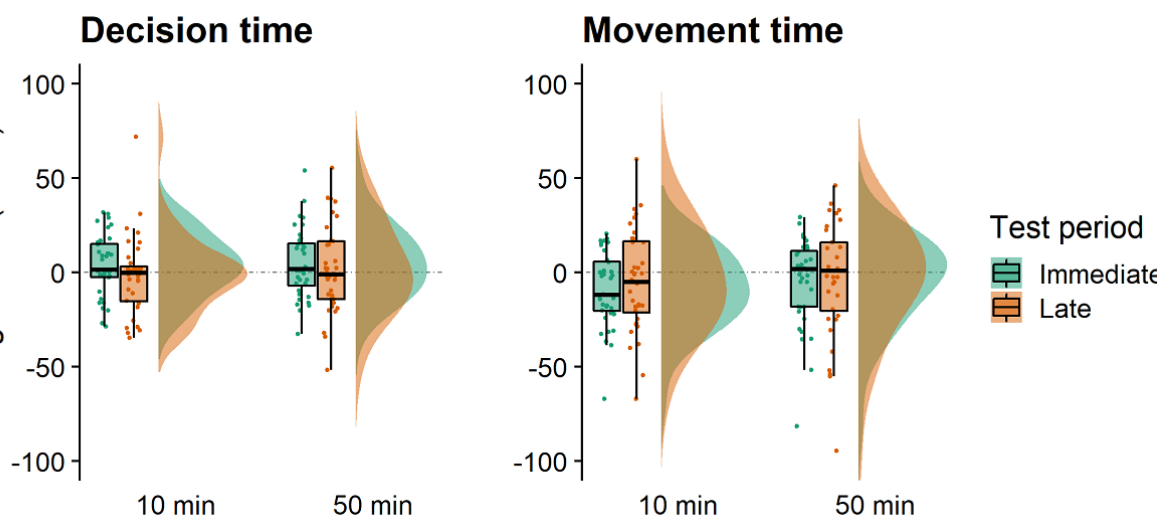
Figure 3. Raincloud plots for the cognitive 5-choice reaction time task showing reaction time (RT) difference scores for the different test periods and virtual reality exposure times. This task captures both decision speeds (left) and movement speeds (right). Positive and negative scores indicate the participant's RTs becoming slower or faster from baseline measurements. RT: reaction time.